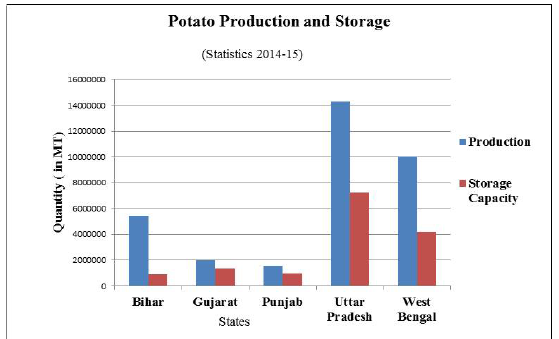
Figure 1. The production of potato crop and storage capacity for